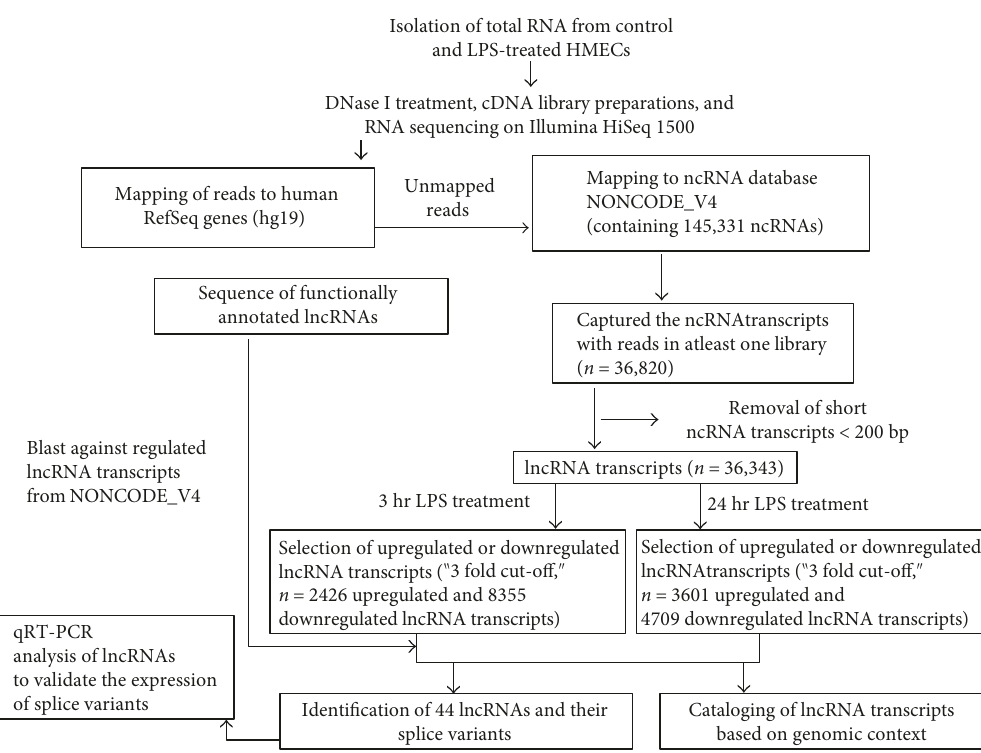
Figure 2: Schematic illustration of the procedure for identi fi cation, cataloging, and validation of lncRNA